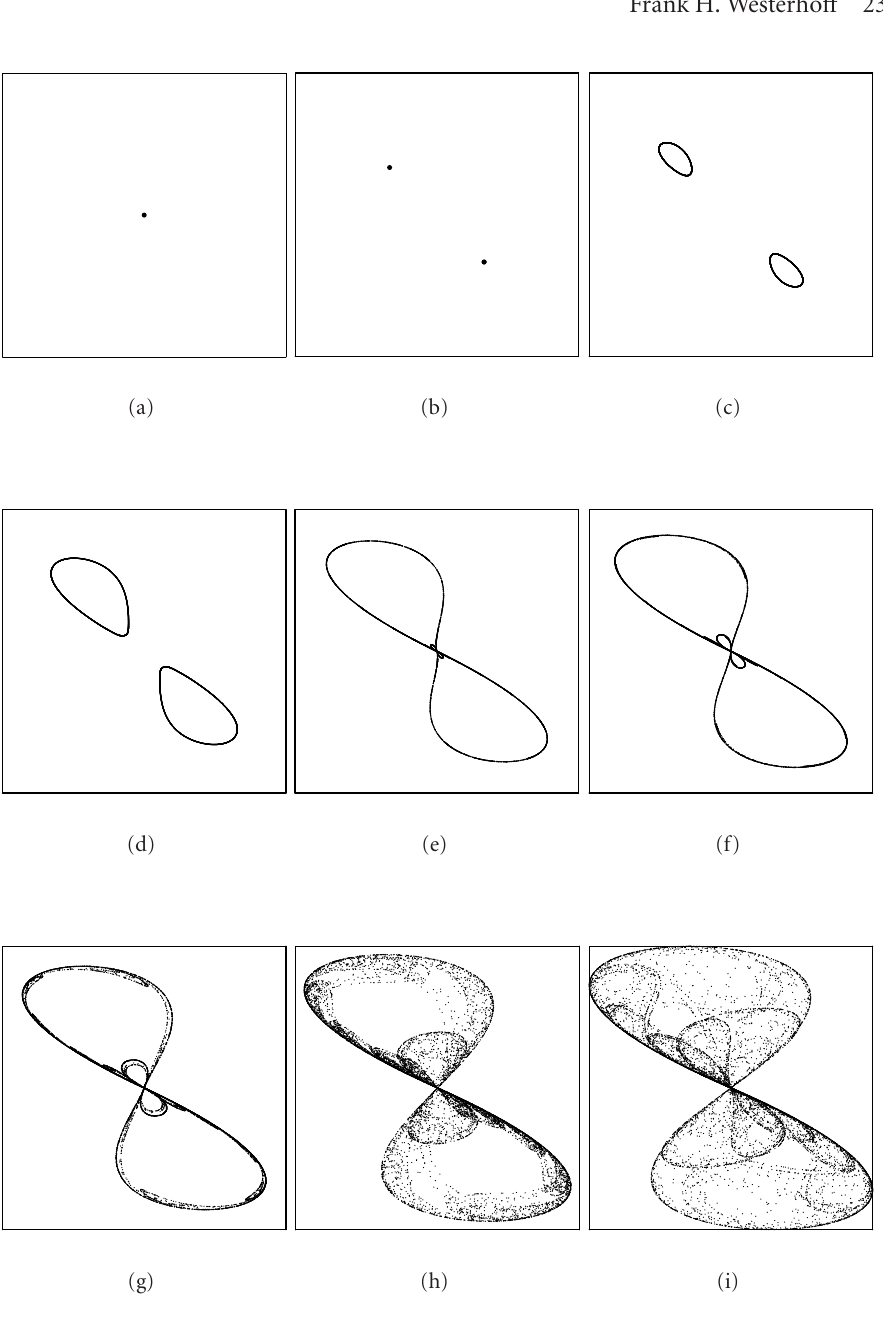
Figure 3.2. The dynamics is phase space. Prices in period t are plotted against prices in period t − 1 for (a) N = 2, (b) N = 2 . 5, (c) N = 2 . 8, (d) N = 2 . 9, (e) N = 3 . 05, (f) N = 3 . 1, (g) N = 3 . 15, (h) N = 3 . 25, and (i) N = 3 . 32. A transient phase of 1000 observations has been